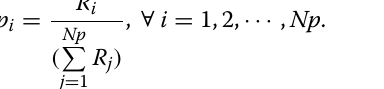
Improved firefly algorithm with courtship learning A careful analysis of the variation curve of male and female individual attraction factor v introduced in